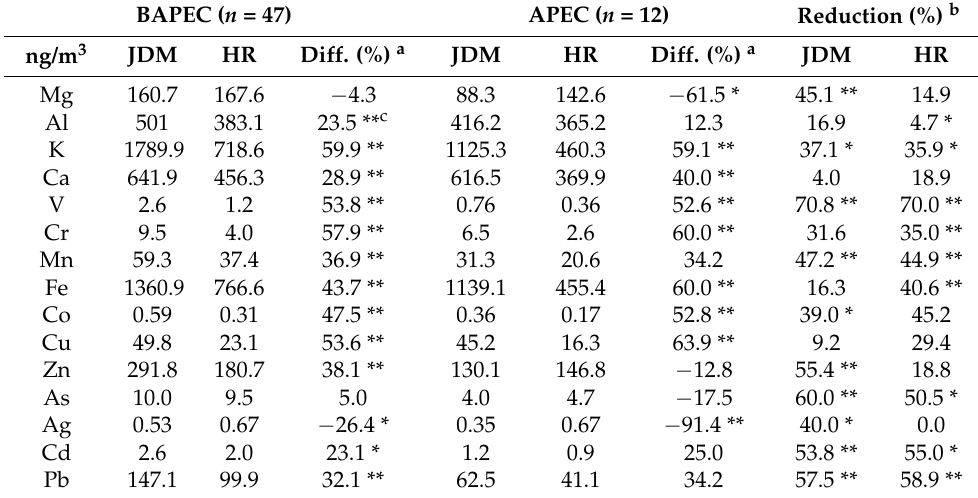
Table 2. Average mass concentrations of metallic elements in PM 2.5 and the differences between urban and suburban site and the reductions between before APEC (BAPEC) and APEC